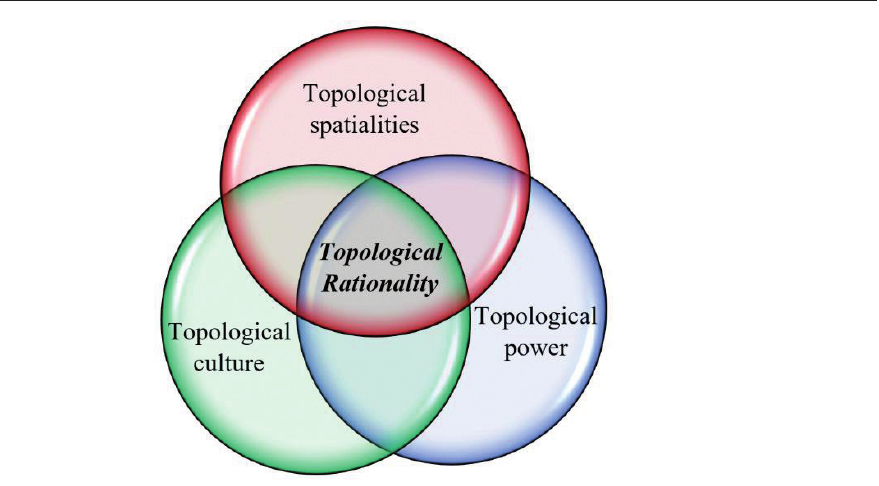
Figure 1: Three axes of topological